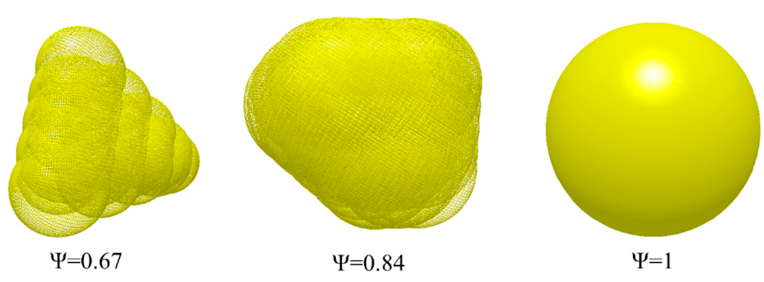
Figure 2. Modeled particles with different sphericity.